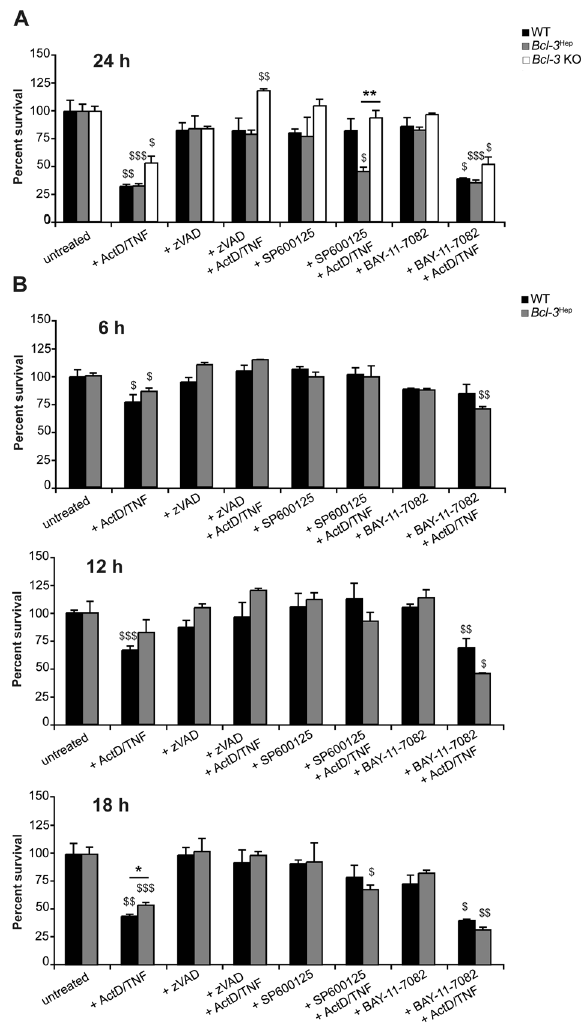
Fig. 4 Rate of TNF-induced hepatocyte cell death in vitro. A Primary hepatocytes derived from Bcl-3 Hep , WT, and Bcl-3 KO mice were treated ex vivo with ActD (200 ng/mL) and TNF (10 ng/mL) to induce TNF-R driven cell death. Pan caspase inhibitor zVAD (50